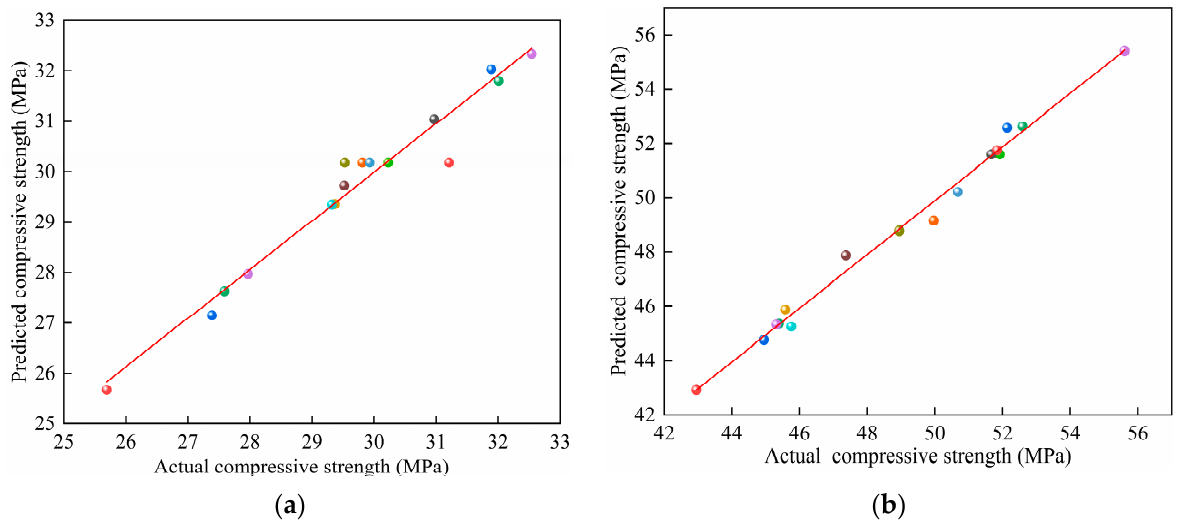
Figure 2. The relationship between the experimental values and predicted values: ( a ) Y 1 and ( b ) Y 2 .